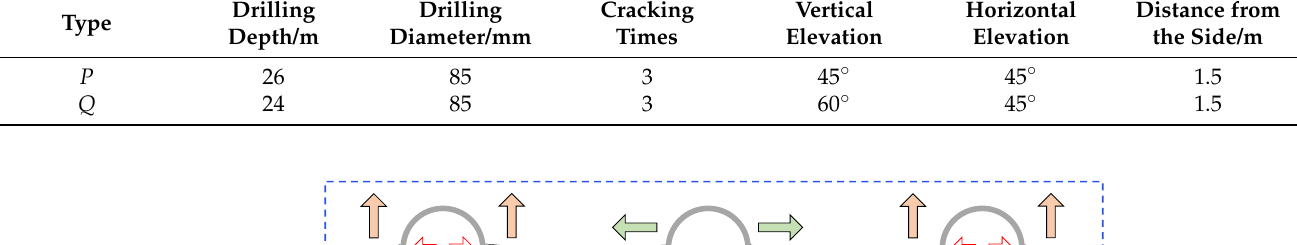
Figure 19. Schematic diagram of the action of the pilot hole and the crack-causing hole. Table 3. Specific parameters of hydraulic fracturing drilling.